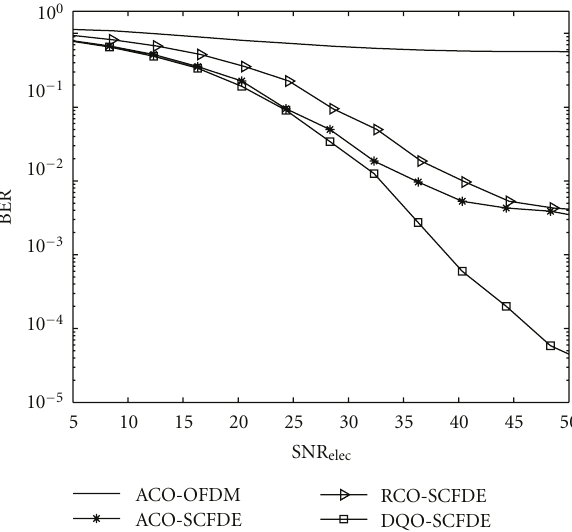
Figure 13: MMSE BER comparison of ACO-OFDM, ACO-SCFDE, RCO-SCFDE, and DQO-SCFDE with N = 64, QPSK input symbols with power 1W and L = 3.